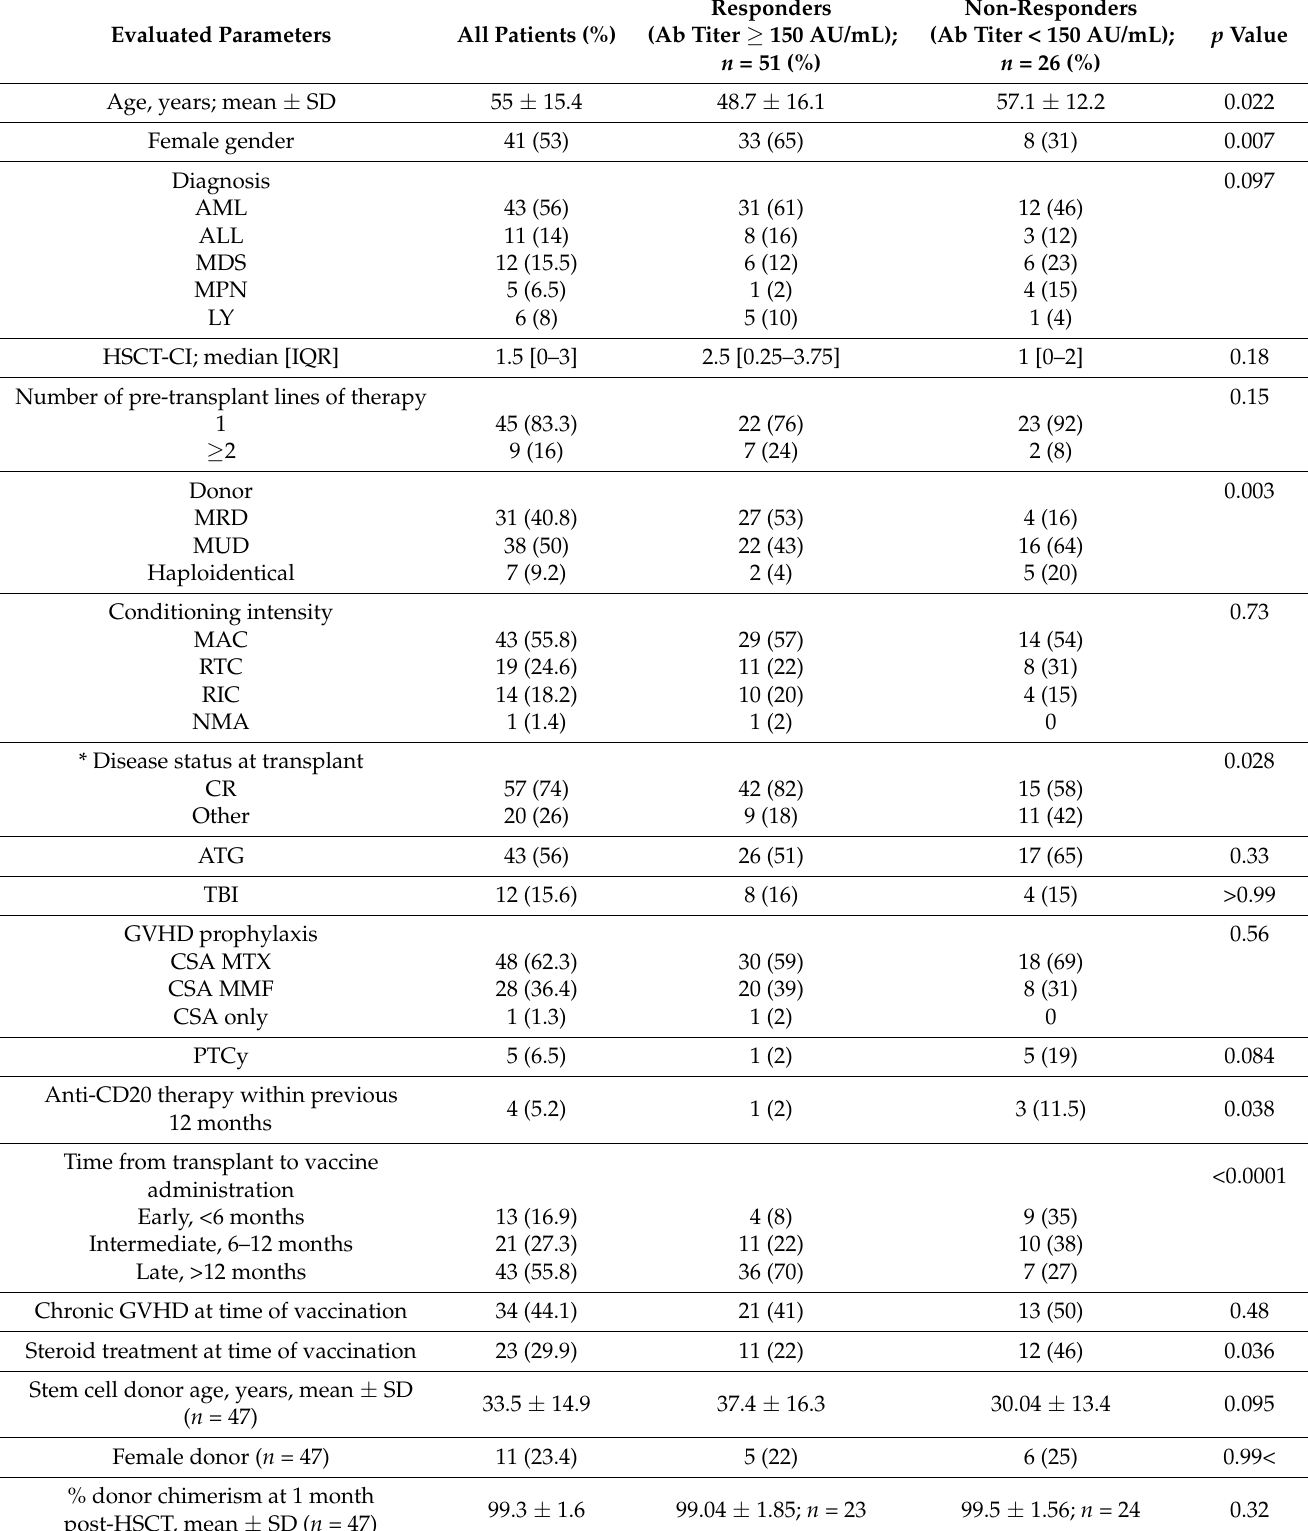
Table 1. Patient characteristics and